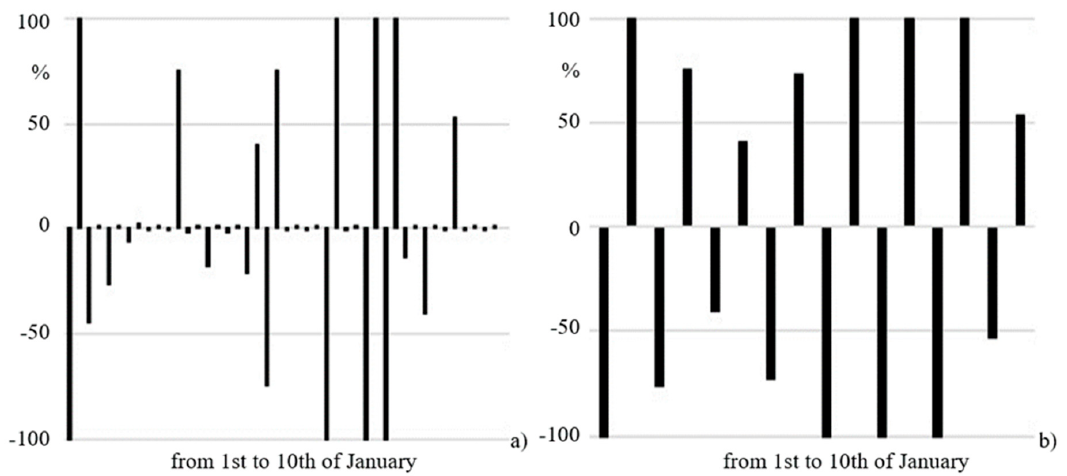
Figure 8. SOC substrings from 1 to 10 January for ( a ) 3 min; and ( b ) 60 min temporal resolution.